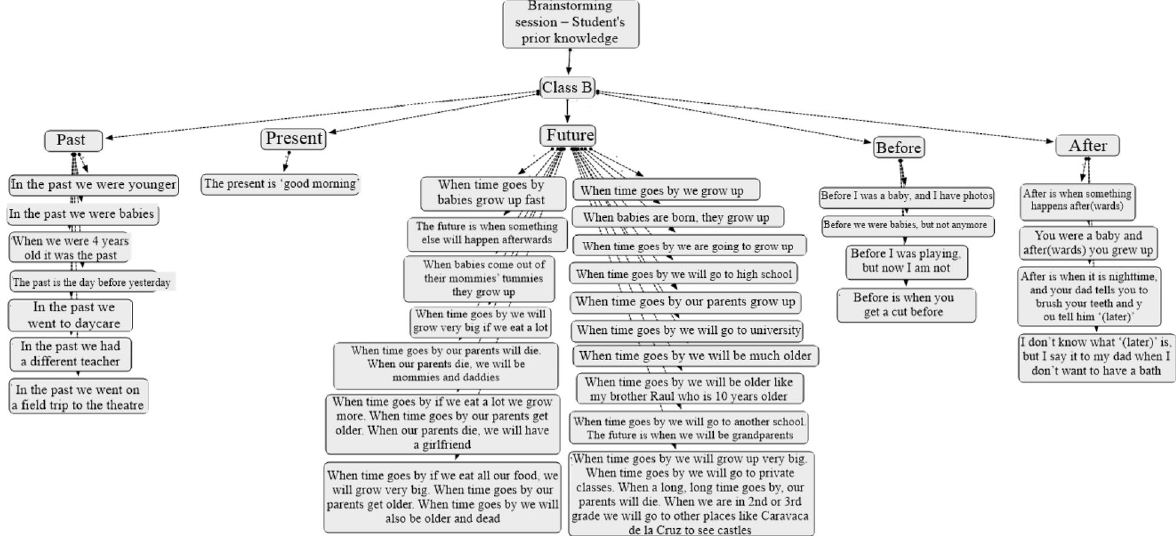
Fig. 4 Semantic network of students ’ prior knowledge from the brainstorming session with class B. This fi gure shows a semantic network of the class B students'